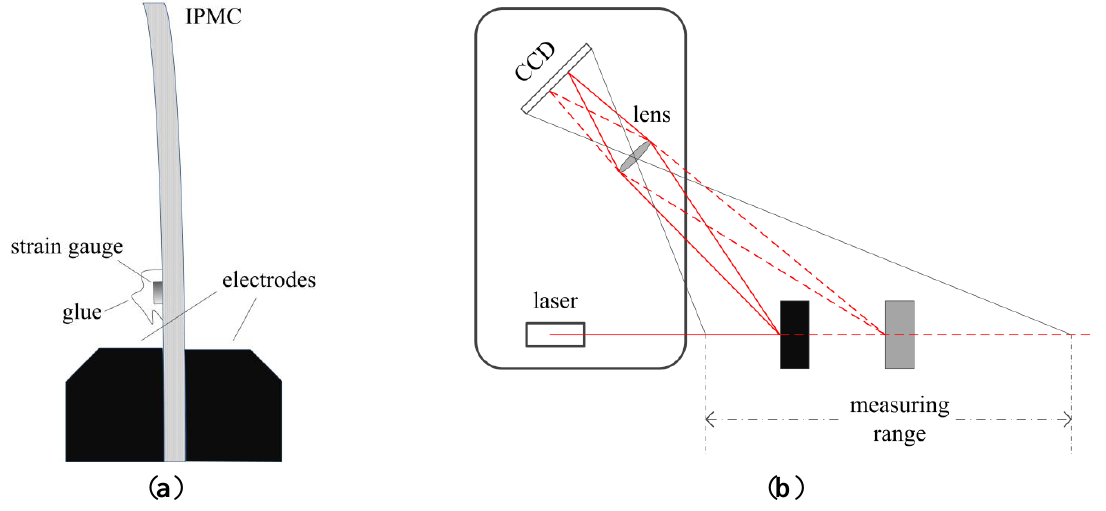
Figure 1. Schematic of ( a ) strain gauge and ( b ) laser gauge